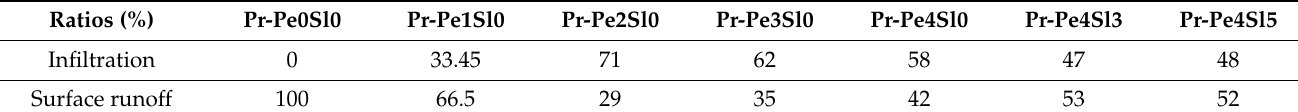
Table 10. Results infiltration and surface runoff ratios.